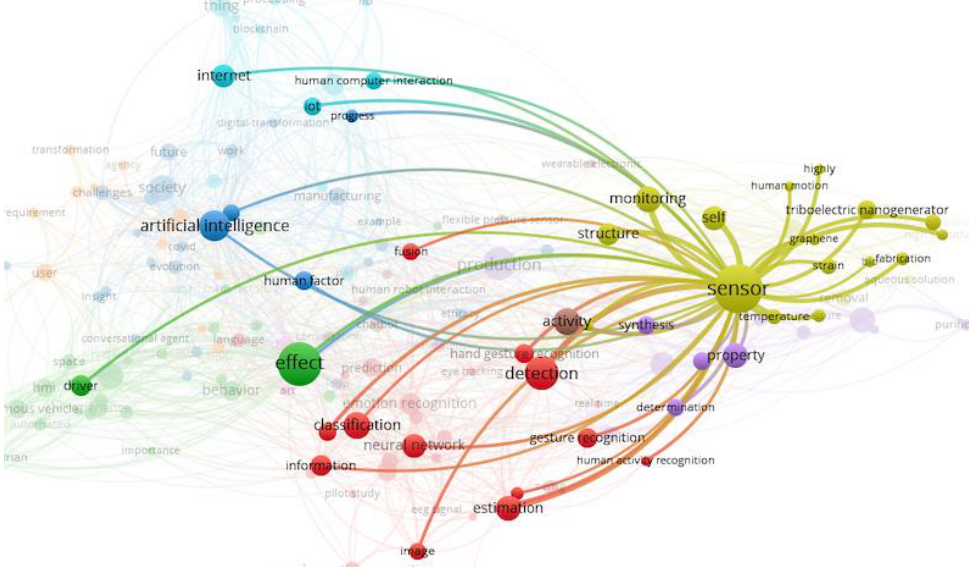
Figure 17. Sensor dependency.